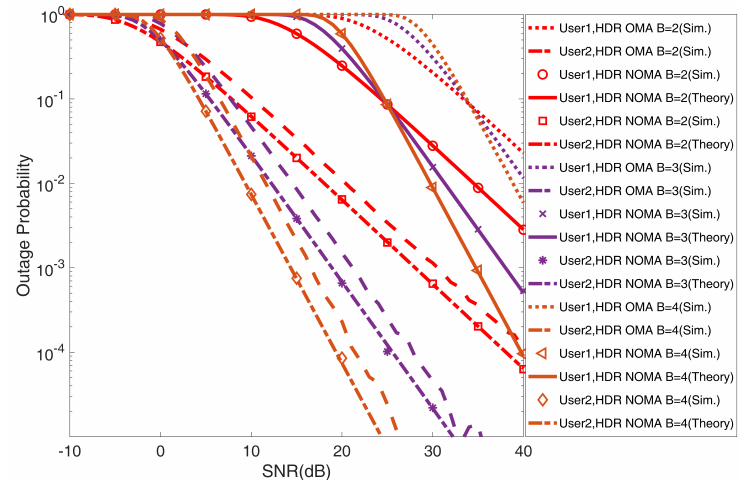
Figure 4. Outage probability versus SNR for U 1 and U 2 under UAV − HDR based − NOMA and OMA schemes.